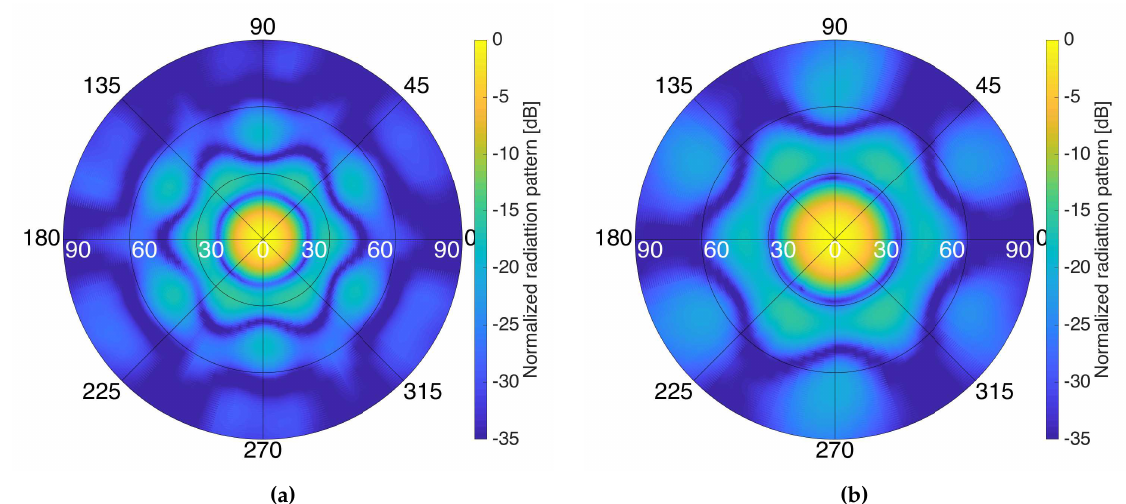
Figure 24. Frontal hemisphere of the measured radiation pattern of the down-looking array, at the L1/E1 ( a ) and at L5/E5 ( b ) frequency